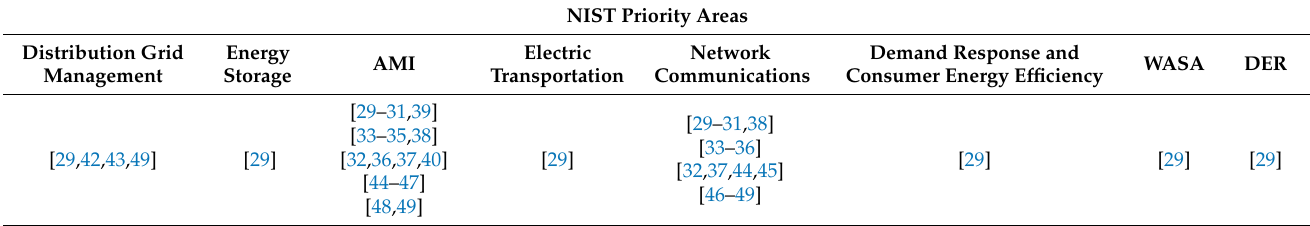
Table 1. Research on trust in Smart Grid categorized based on NIST priority areas.